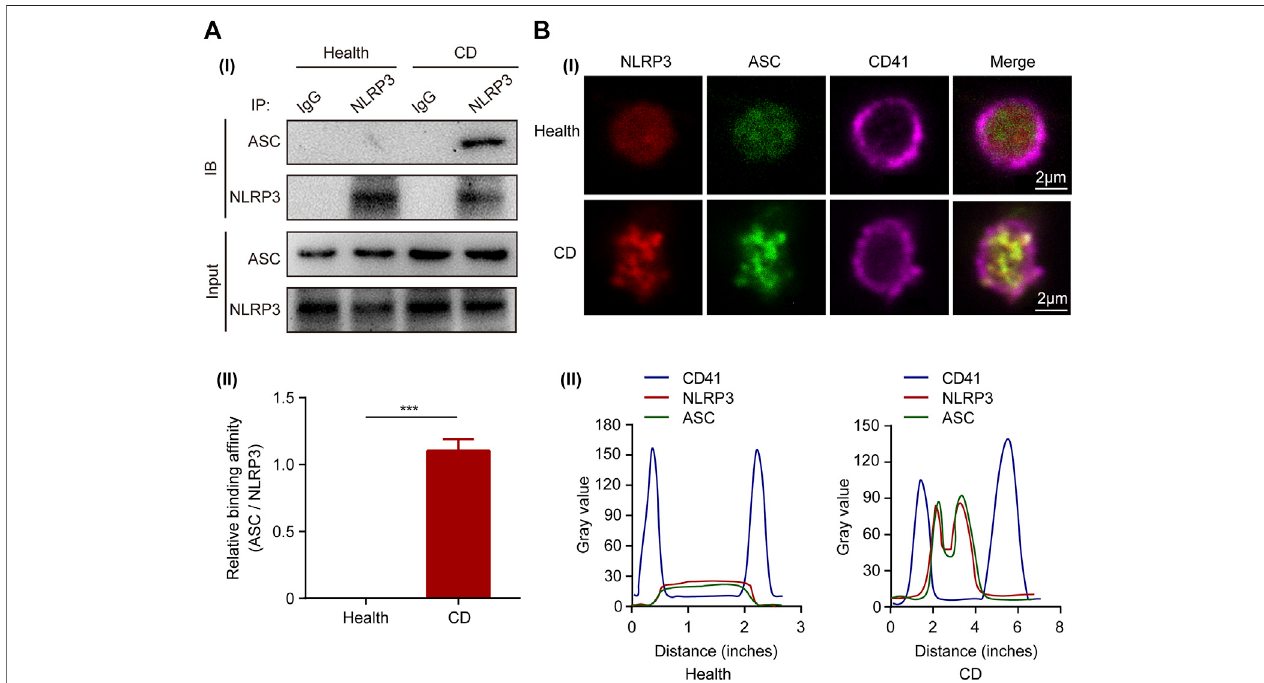
FIGURE 2 | Activation of NLRP3 in fl ammasome in platelets from patients with active Crohn ’ s disease (CD). (A) Co-immunoprecipitation of ASC with NLRP3 in platelets from the healthy group and patients with active CD (i) . Quanti fi cation of the interaction between ASC and NLRP3 in platelets was below ( n (cid:2) 3), (ii ). (B) Immuno fl uorescence staining showed colocalization of ASC (green) and NLRP3 (red) in platelets from patients with active CD (i) . The experiment was repeated three times. Intensity traces were plotted below (ii) . Scale bars were 20 μ m. Health, the healthy group; CD, the patients with active Crohn ’ s disease. Data are presented as mean ± SD, *** p <